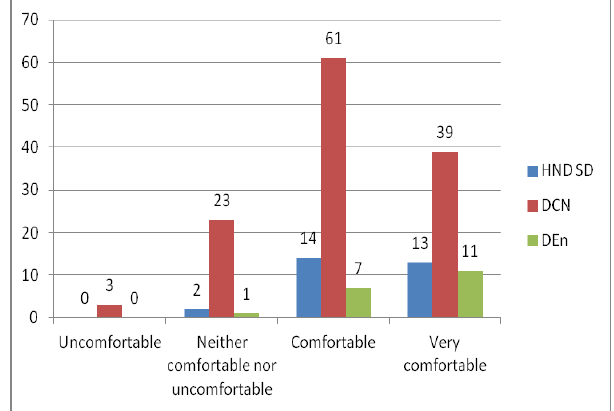
Figure 3. Ease of use of computer by course